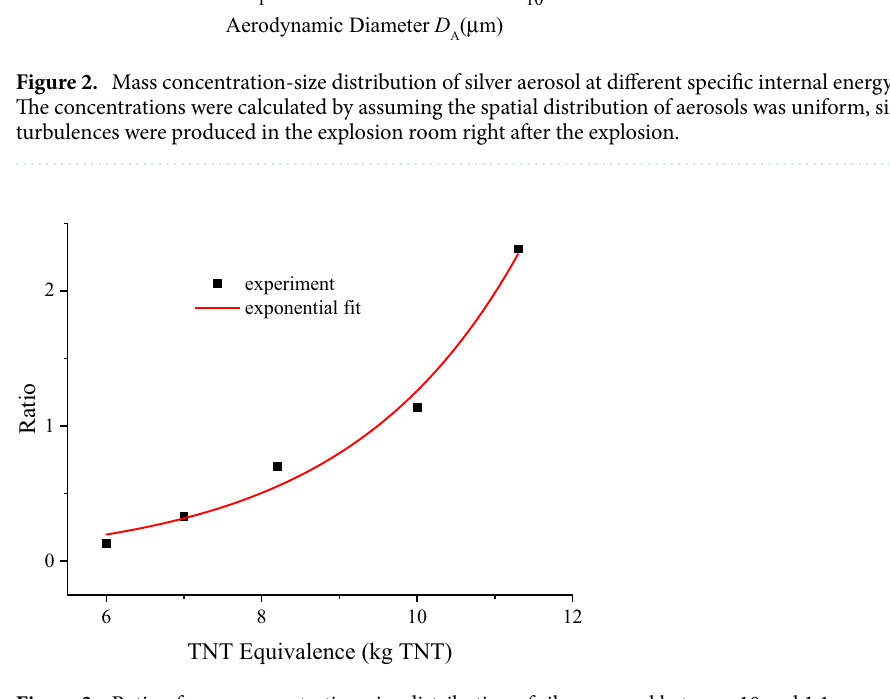
Figure 3. Ratio of mass concentration-size distribution of silver aerosol between 10 and 1.1 µm, versus TNT equivalence. As the sampled mass of silver aerosol for 0.301 MJ/kg is too low to detect accurately, the data for 0.301 MJ/kg is not given. An exponential fit is applied and presented by red line, which shows a clear exponential increase tendency of the data